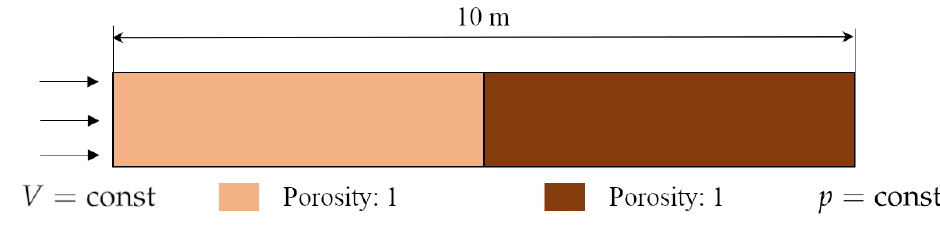
Figure 3. Schematic representation of the problem of continuous injection in the area containing zones with different porosities and permeabilities.